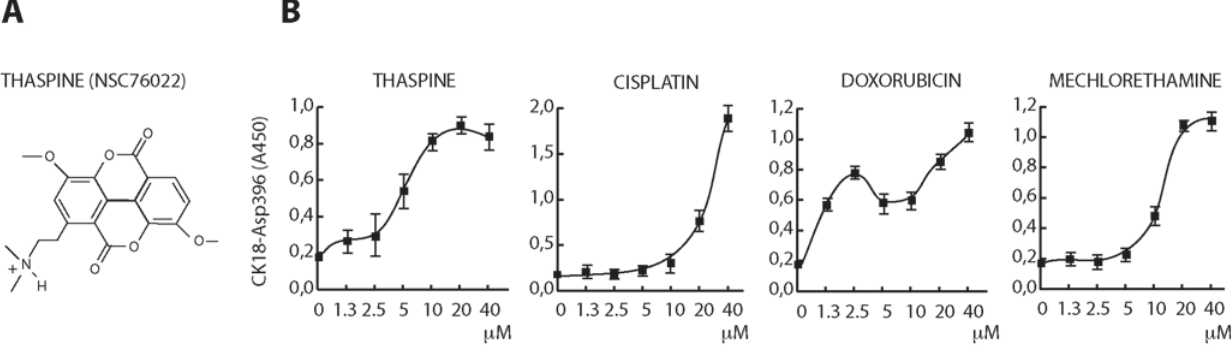
Figure 1. Induction of apoptosis by thaspine. (A) chemical structure of thaspine (NSC76022); (B) induction of caspase-cleaved CK18 by thaspine, cisplatin, doxorubicin and mechlorethamine in HCT116 colon carcinoma cells. Treatment was for 24 hours with the indicated concentrations of compounds. Cells were lysed and CK18-Asp396 was determined using the M30 CytoDeath ELISA. Results are shown with S.D. from triplicate determinations. Similar results (including the biphasic response to doxorubicin) were observed in independent experiments.